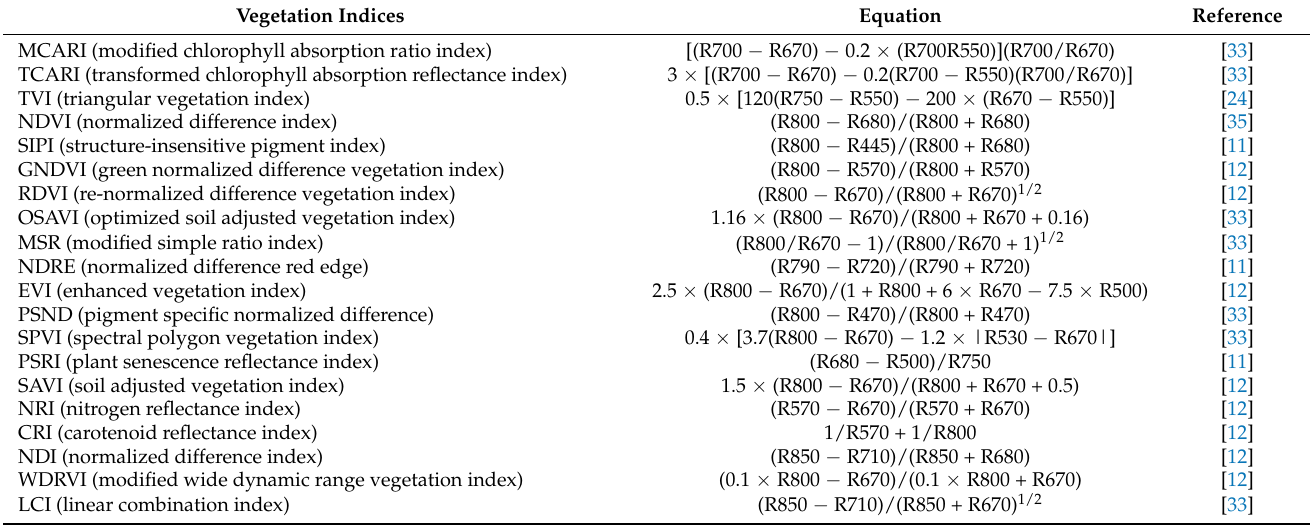
Table 2. Vegetation indexes used in the